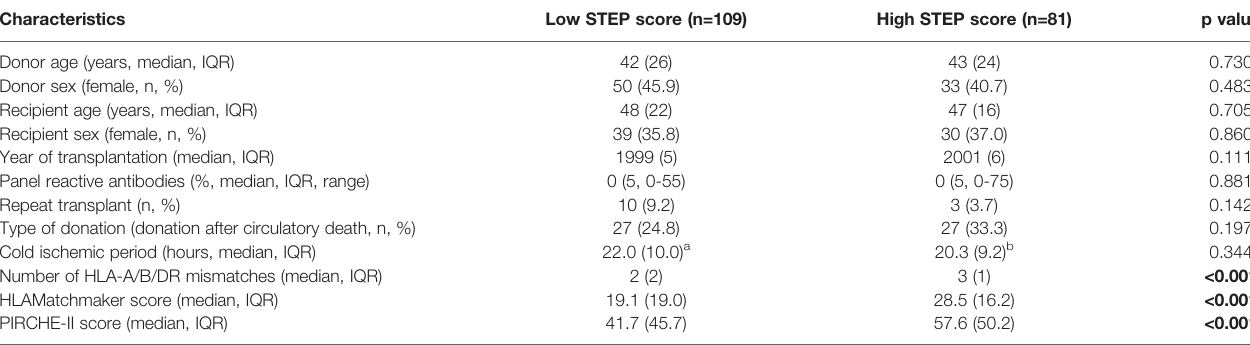
TABLE 3 | Baseline characteristics of recipients with a low STEP score ( ≤ 0.21) and recipients with a high STEP score (> 0.21).